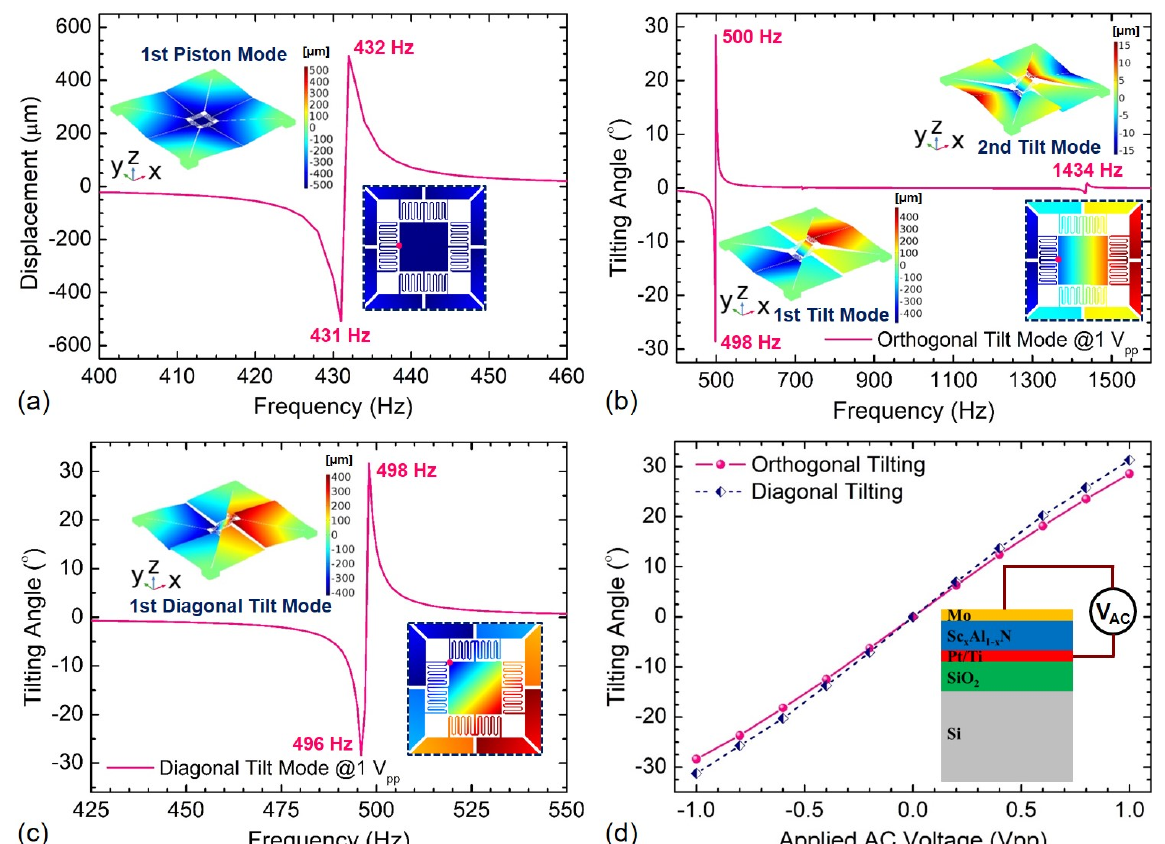
Figure 12. Frequency response of Device A: ( a ) displacement at the piston mode, ( b ) tilting angle at the 1st and 2nd orthogonal tilt modes, ( c ) tilting angle at the diagonal tilt mode, ( d ) tilting angle vs applied AC voltage.